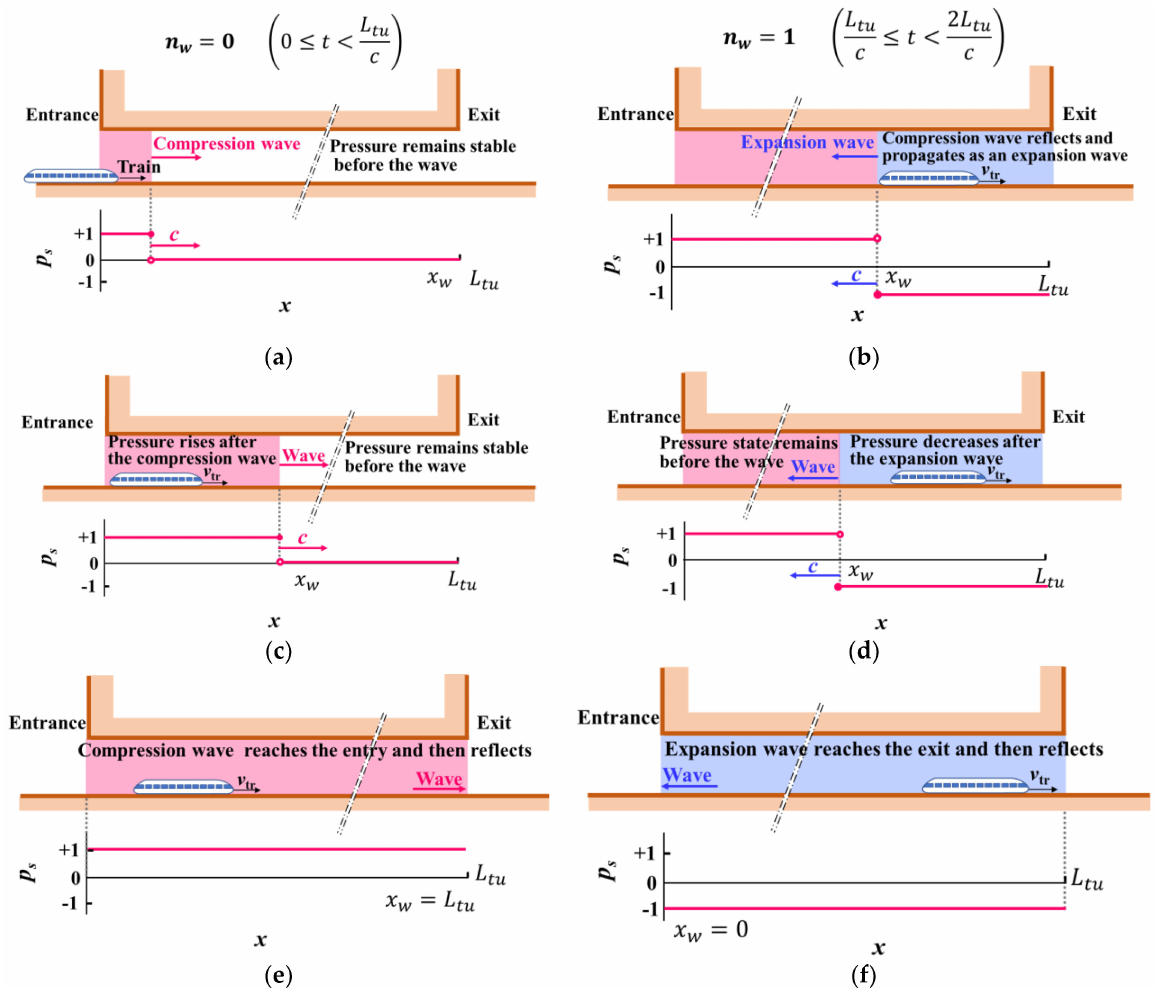
Figure 3. Schematic of pressure wave propagation and the associated distribution of pressure state: ( a , c , e ) n w = 0; ( b , d , f ) n w = 1. ( p s : pressure state; n w : the reflected times of the wave at the tunnel port; x w : the location of pressure wave; L tu : tunnel length; v tr : train speed; c : the velocity of